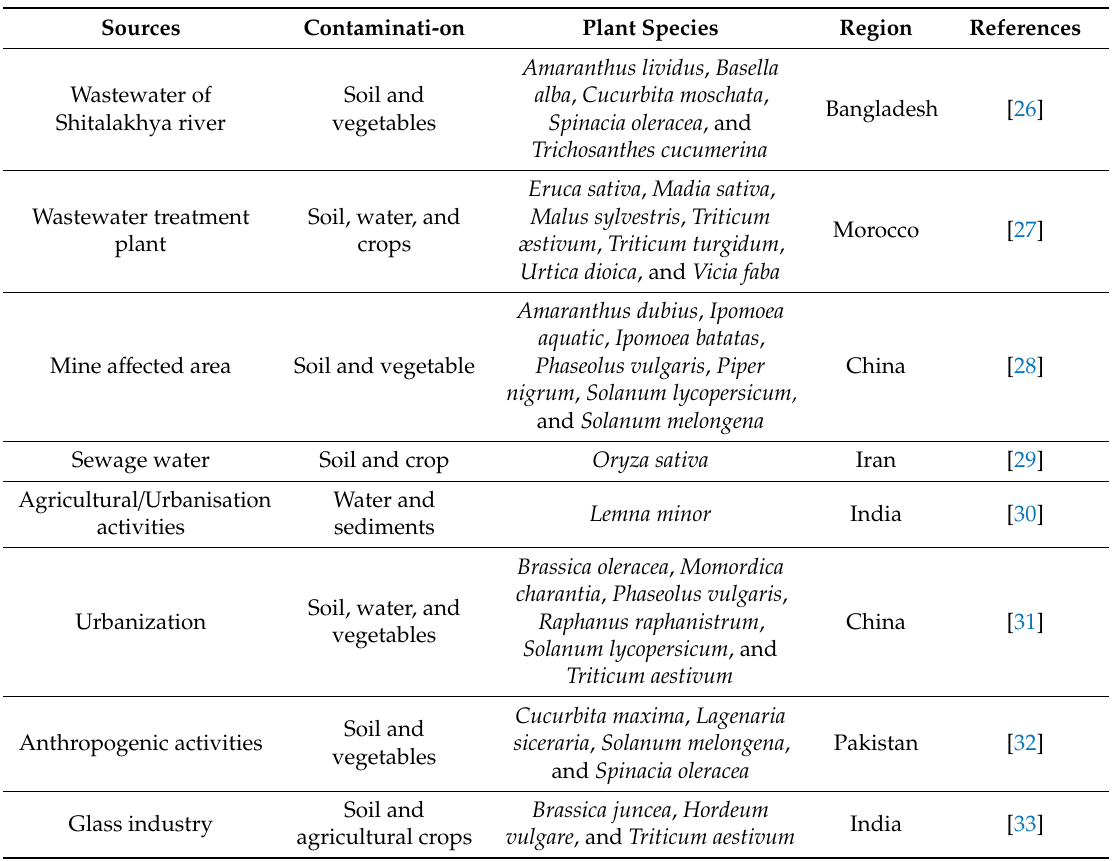
Table 1. Table of Pb contamination in agricultural soils, crops, and water in di ff erent countries [18].